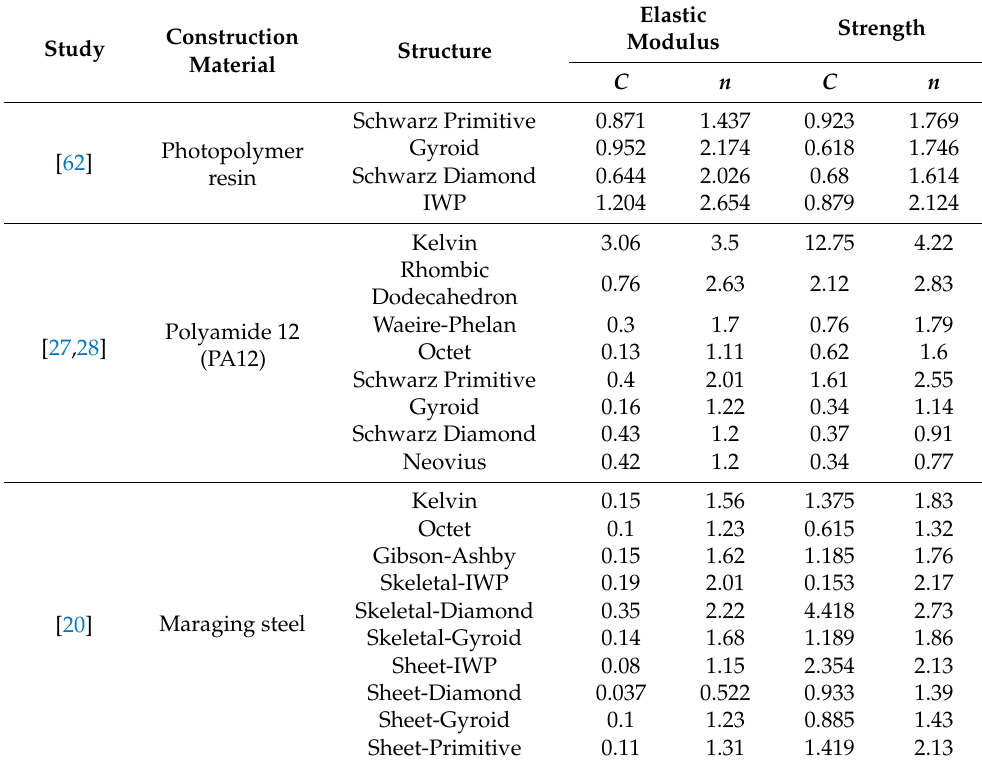
Table 1. Scaling laws constants for different architected materials from published studies.